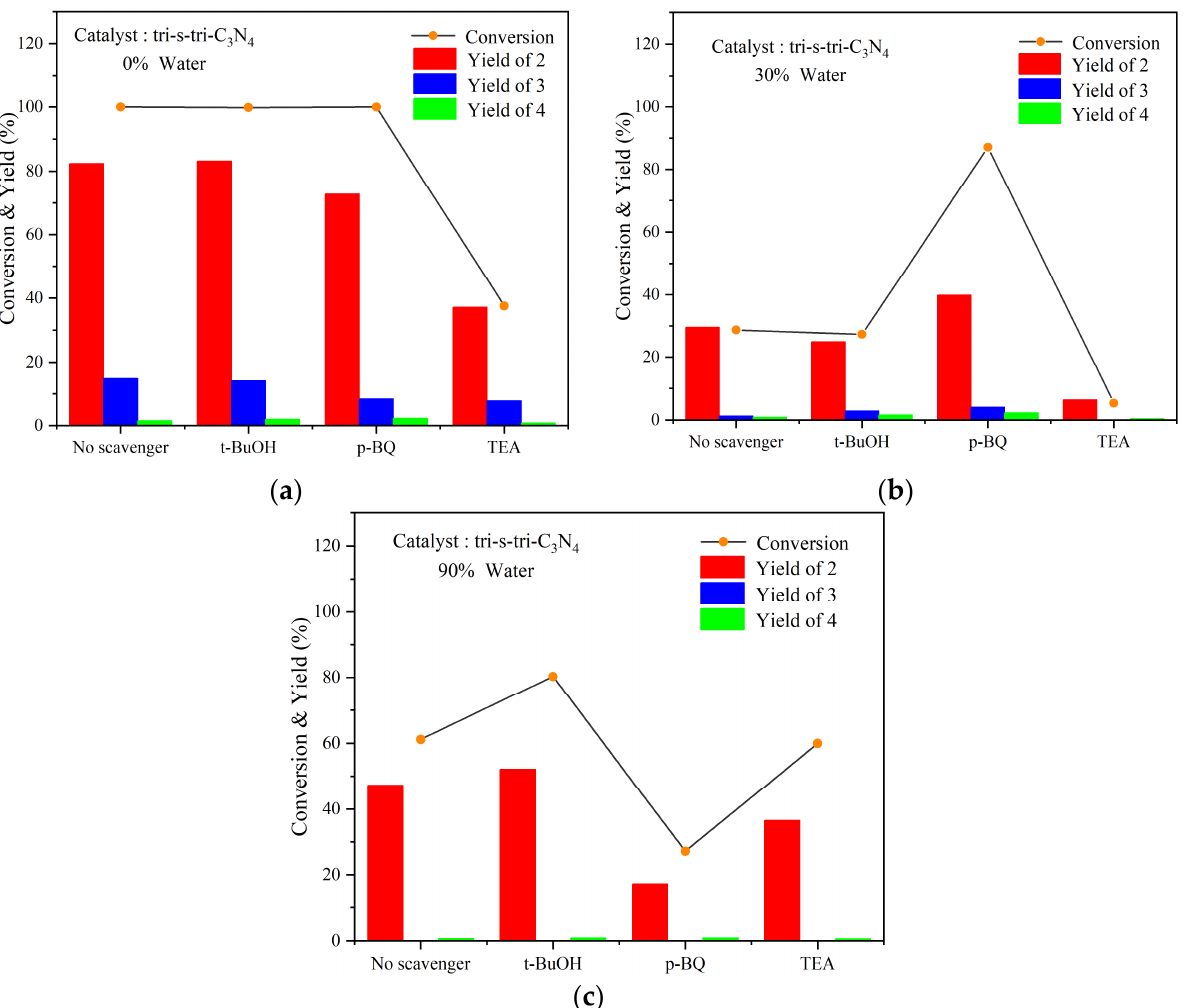
Figure 12. Effect of adding free-radical-quenching agents to ( a ) 0% water, ( b ) 30% water, and ( c ) 90% water with tri-s-tri-C 3 N 4 as catalyst. (The concentration of the scavengers was 2 mM). When p-benzoquinone (p-BQ) was used as the O 2 − quenching agent, both the con- version rate of the substrate and the product yield in the acetonitrile solvent were slightly reduced. This indicated the presence of · O 2 − in the process, which also suggested that tri-s-tri-C 3 N 4 could transfer electrons to oxygen to produce · O 2 − . However, the addition of benzoquinone to the water–acetonitrile (30/70, v/v ) solvent accelerated the conversion